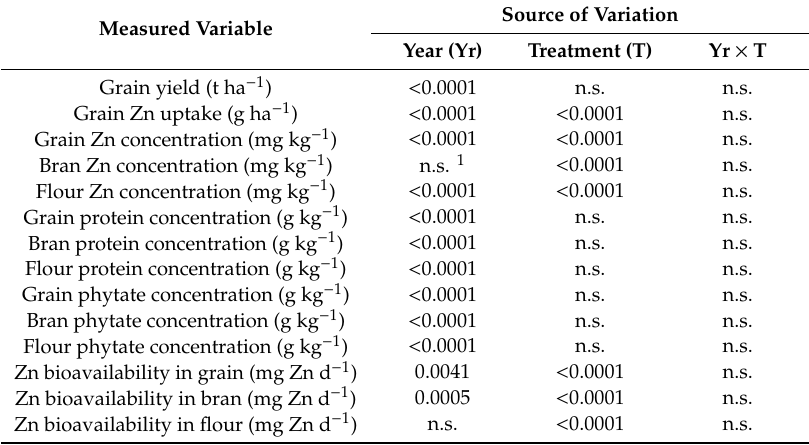
Table 1. Significance level of the fixed e ff ects for each of the measured